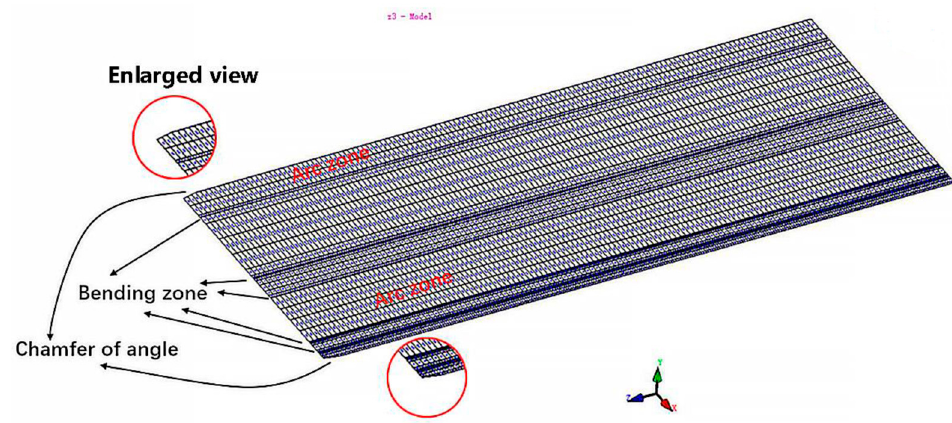
Figure 3. Strip meshing.